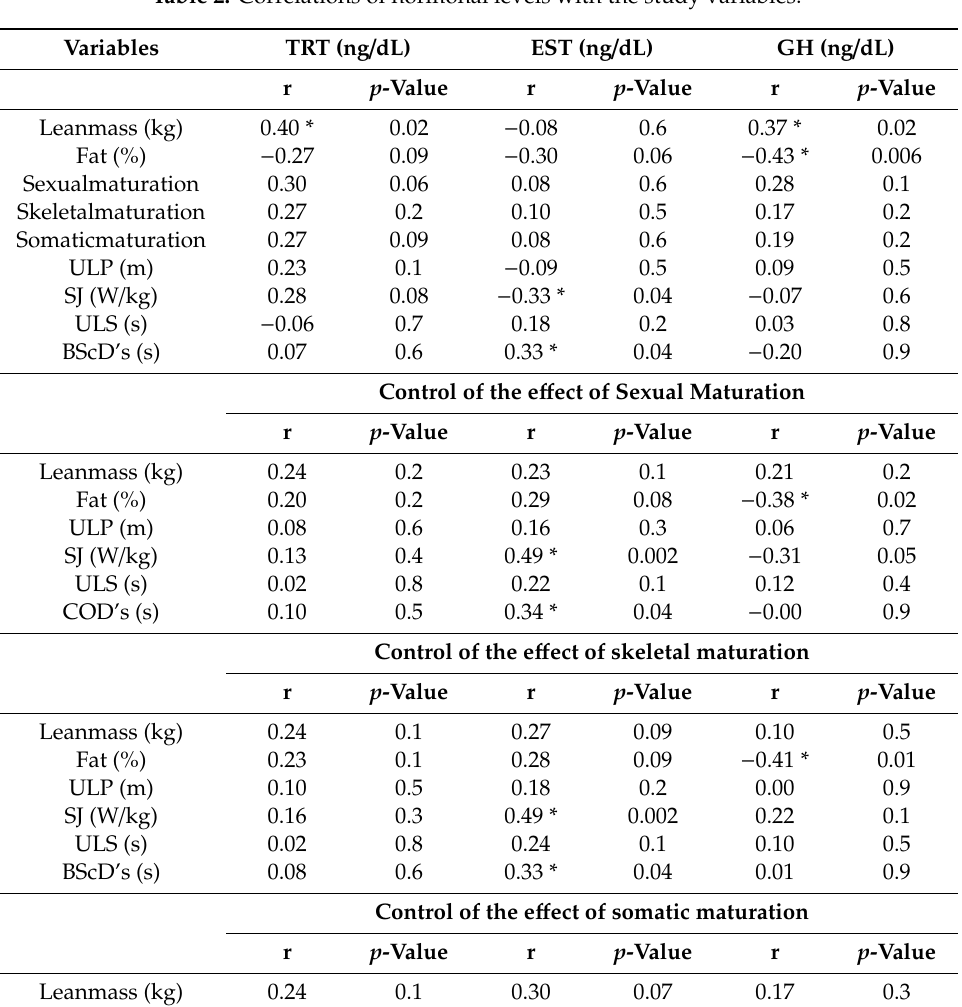
Table 2. Correlations of hormonal levels with the study